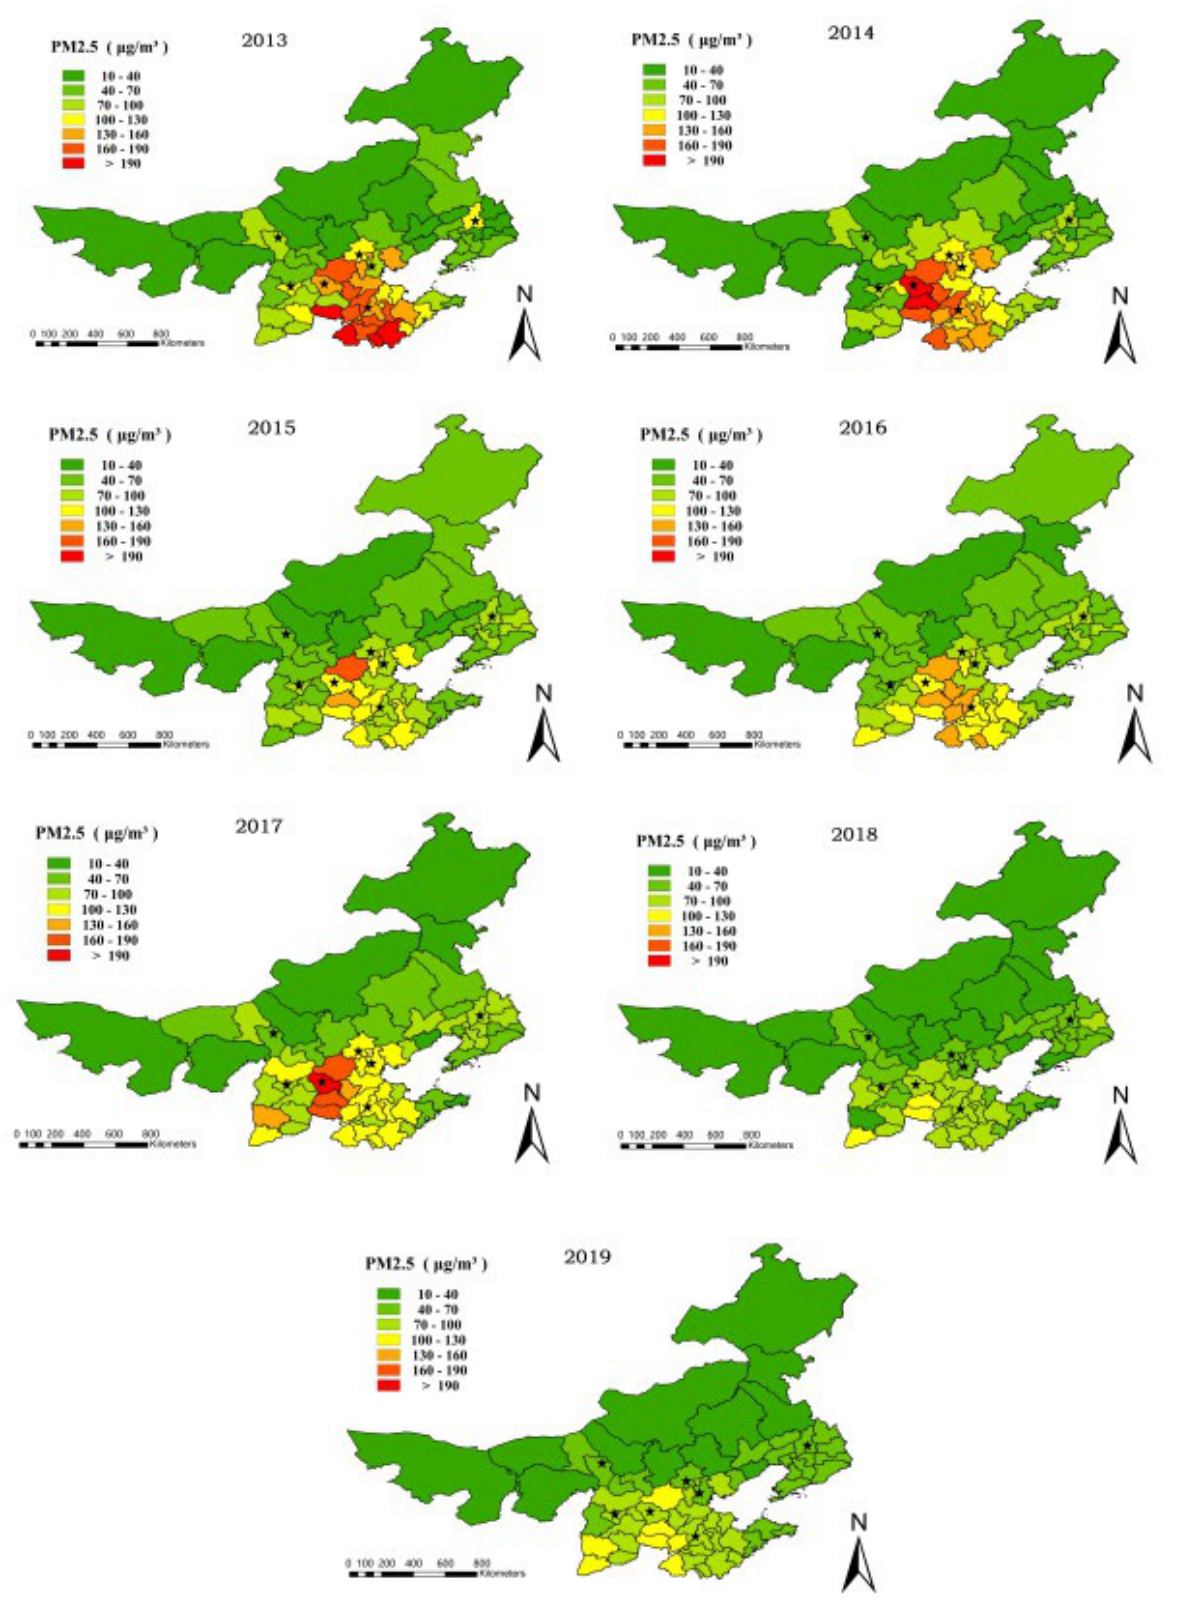
Figure 5. PM2.5 concentrations have a temporal and spatial distribution. (The stars indicate the capitals of seven provinces).